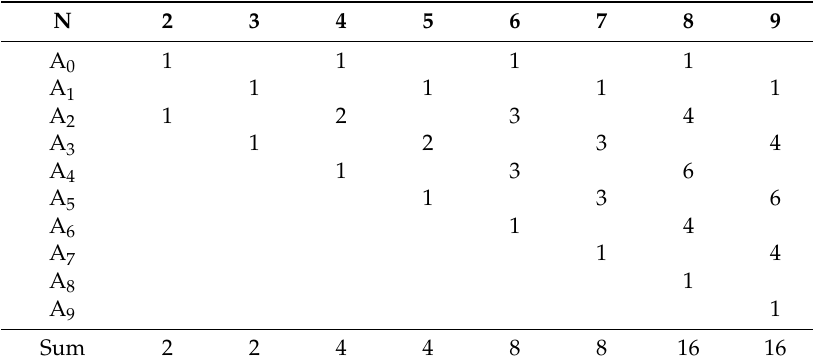
Table 1. Number of terms of the polynomial Pascal for every coefficient (N = 2–9). N